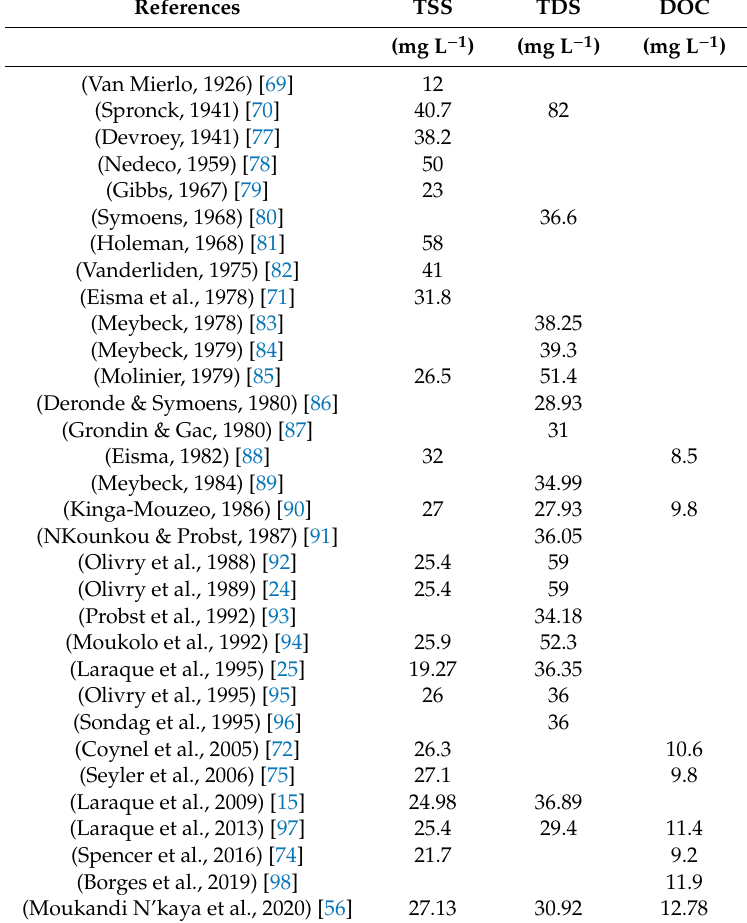
Table 3. Chronological compilation of TSS, TDS, and DOC concentrations since the beginning of the studies on Congo River quality at Brazzaville / Kinshasa gauging